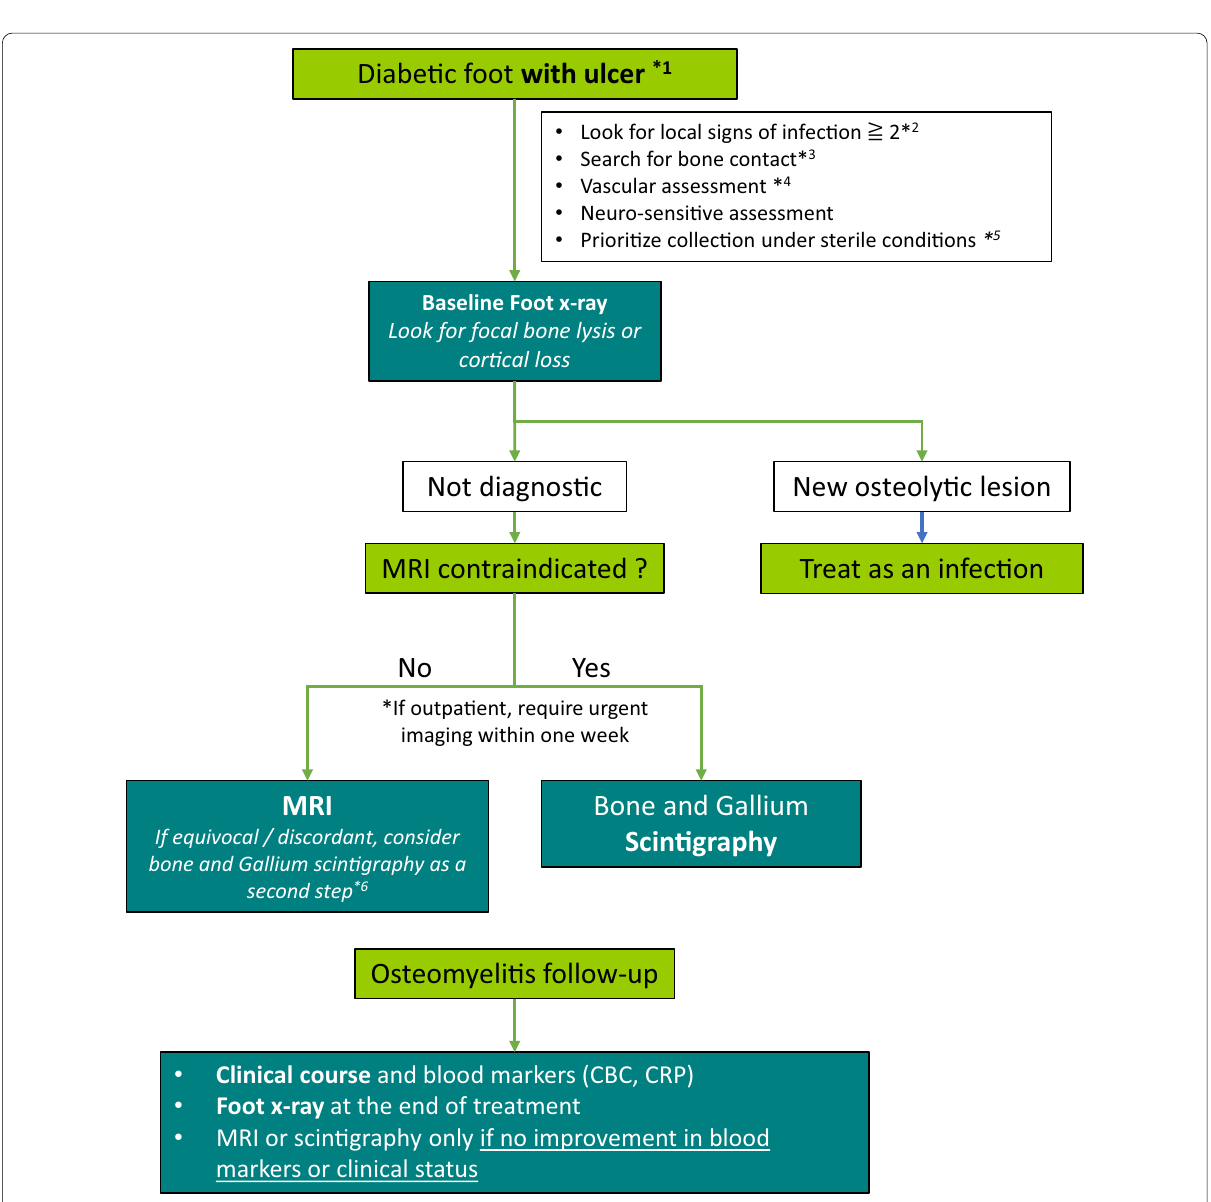
Fig. 1 Proposed diabetic foot investigation algorithm. *1: if no ulcer/orifice, osteomyelitis is unlikely and consider another diagnosis and scintigraphy *2: according to IDSA: swelling, redness, pain, heat or purulent discharge *3: bone exposure or bone contact with the metal probe *4: consider arterial Doppler or consultation in vascular surgery if pulse absent / decreased *5: Superficial swabs are not recommended *6: Scintigraphy could be an alternative to first‑line